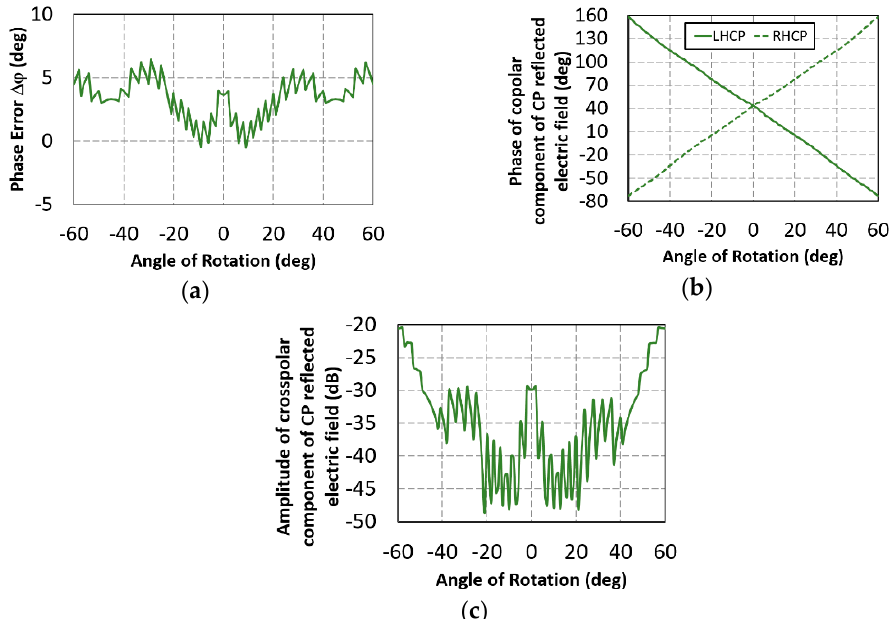
Figure 6. Electromagnetic response of the optimized cell provided by the unit cell at 19.7 GHz as a function of the rotation angle. ( a ) Phase error ∆ ϕ produced in the 180deg of di ff erence of phase between the reflection coe ffi cients R x’x ’ and R y’y’ . ( b ) Phases of the reflected electric fields of the co-polar circular polarized waves. ( c ) Amplitude of the reflected electric field of the cross-polar circularly polarized wave for an RHCP incident wave.